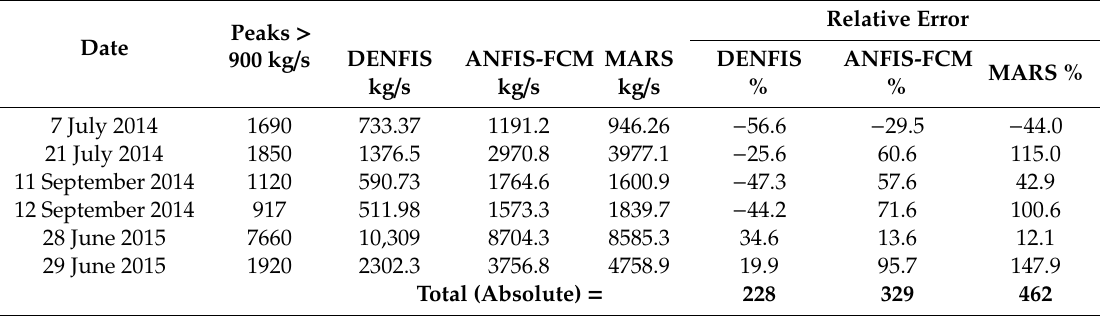
Table 4. The comparison of DENFIS, ANFIS-FCM and MARS peak-estimates for the test period, Guangyuan Station.